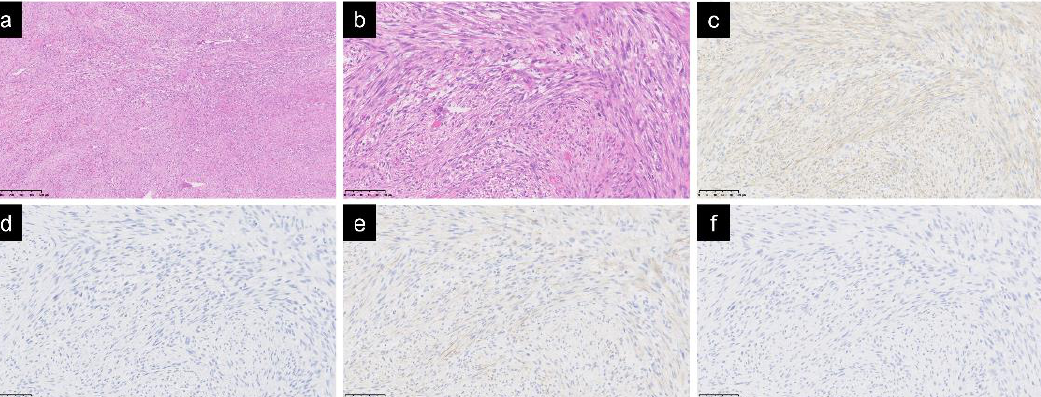
Figure 1. Spindle cells with mild atypia were observed with irregular fascicles. Hematoxylin and eosin staining: magnification ×50 ( a ); magnification ×200 ( b ). In an immunochemical study of muscle markers, α-SMA was positive ( c ), desmin was negative ( d ), calponin was positive ( e ), and h-caldesmon was negative ( f ); (( c – f ) magnification ×200).